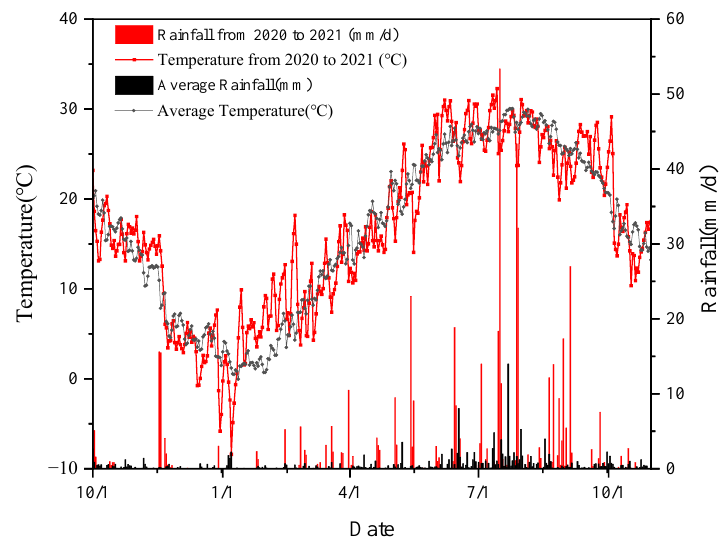
Figure 16. Variation in rainfall and temperature during the crop-growing season.